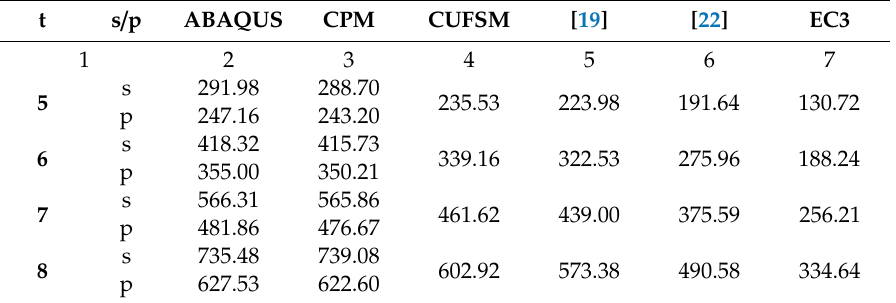
Table 2. Comparison of critical stresses determined by several methods for the I-300 × t × 250 × t section and four wall thickness